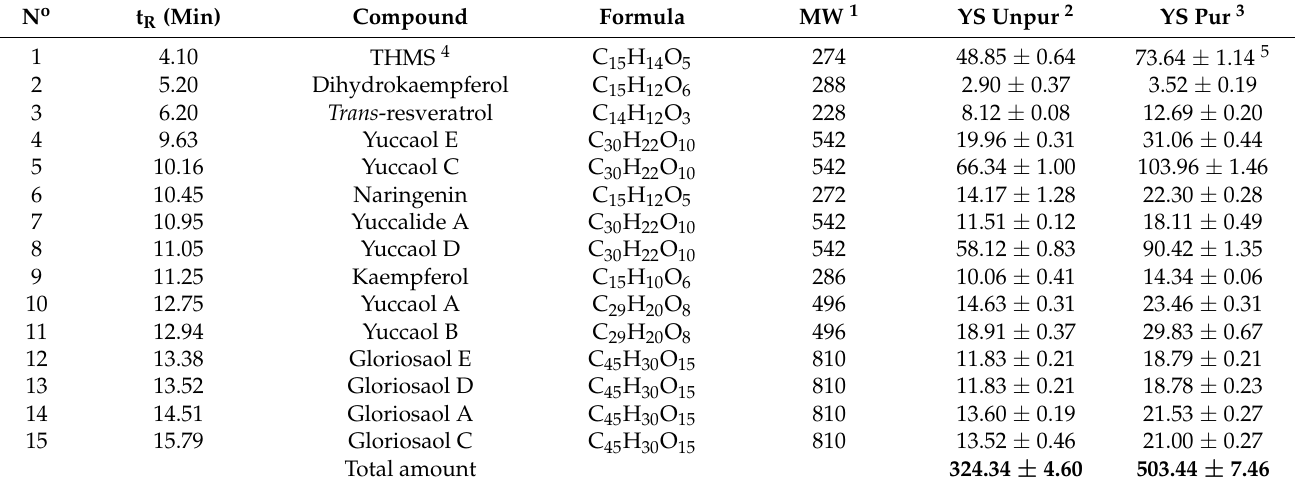
Table 1. Individual and total phenolic content (mg/g) of YS unpurified and purified phenolic fractions, using